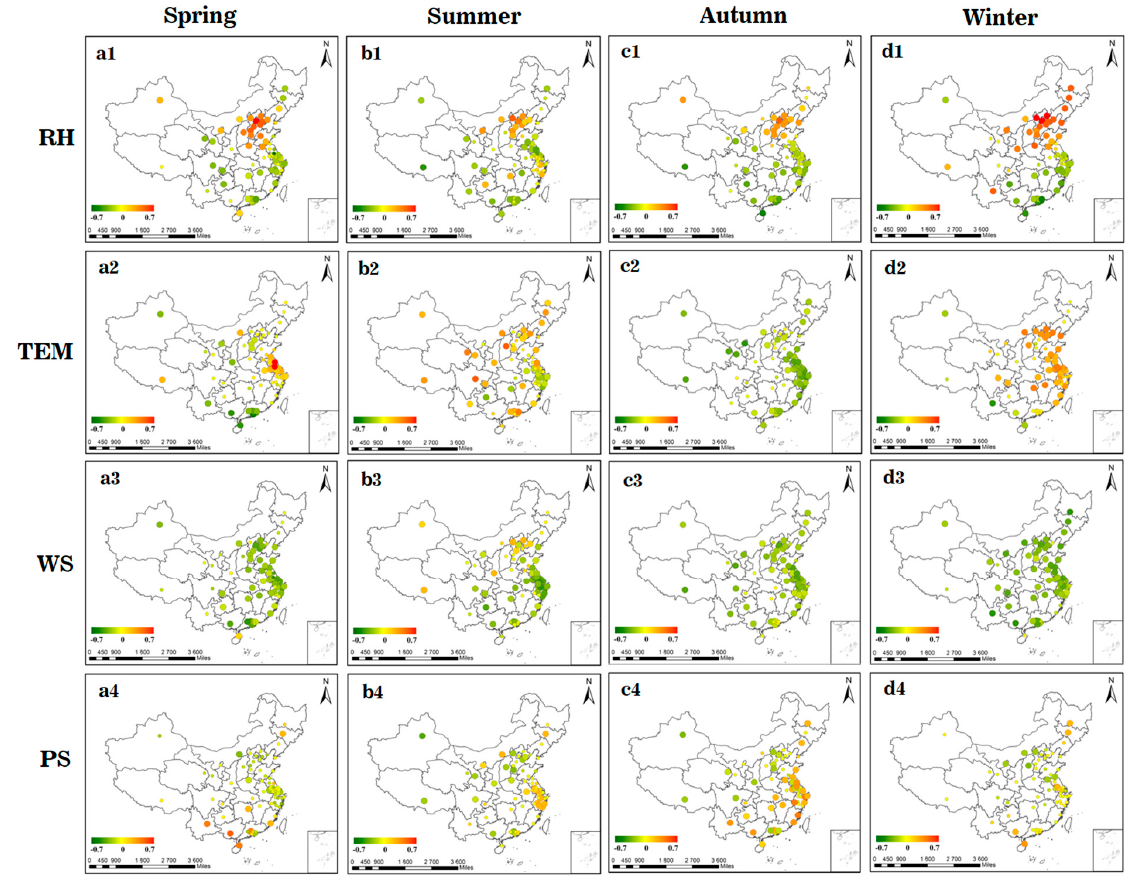
Figure 9. The distribution of the correlation coefficient (r) values in the four seasons.